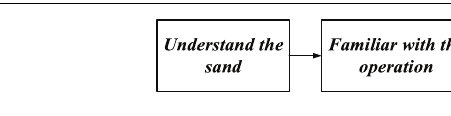
Interactivity means that users can operate objects in the virtual world and get feedback. For example, users can grasp an object with their hands in the virtual world, recognize the shape of the object with their eyes, weigh an object with their hands, and the object can be easily manipulated and moved. Imagination means that the virtual world has greatly broadened the imagination of people in the real world. Under a VR environment, people can imagine a world or situations beyond the objective world. VR can be divided into four categories, namely, non-immersive VR, immersive VR, distributed VR system, and AR system. Figure 5 reveals the VR-based Sand Table game treatment process, and Table 2 indicates the specific explanation of the treatment process. VR technology is divided into the desktop VR (DVR)